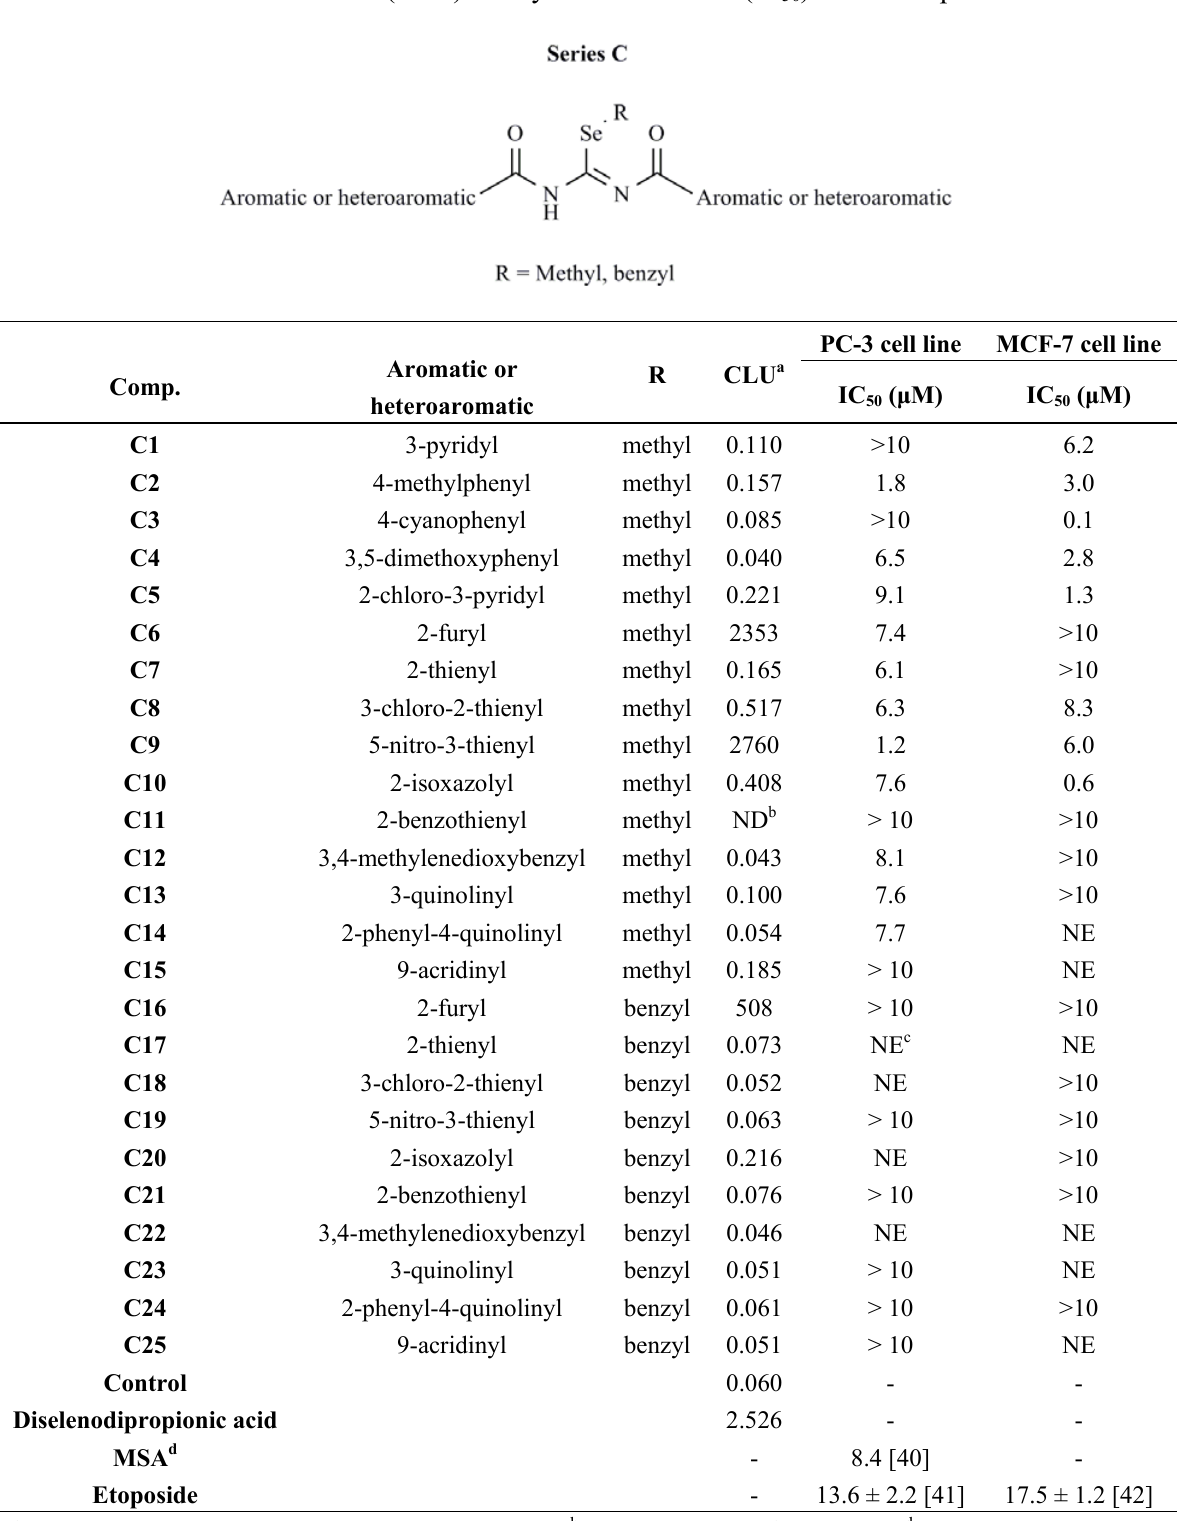
Table 3. Chemiluminescence (CLU) and cytotoxic activities (IC